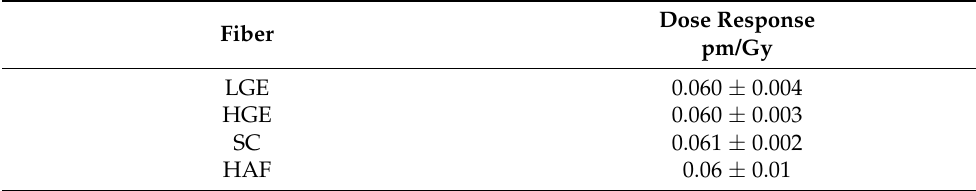
Figure 7. Bragg wavelength shift in terms of dose using fiber doped with germanium at low concentration (LGE), germanium at high concentration (HGE), no doping, i.e., pure silica core (SC) and cobalt (HAF) using a PMMA plate as coating (5.5 × 107.5 × 205 mm 3 ) and 6 MV beam. Table 3. Dose response for different fiber core compositions using a PMMA plate as coating (5.5 × 107.5 × 205 mm 3